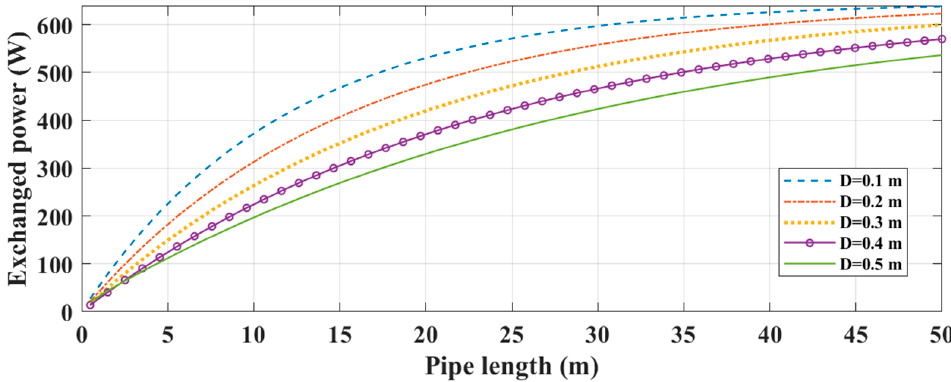
Figure 8. Exchanged heat power of the EAHE system as a function of pipes length and diameter.